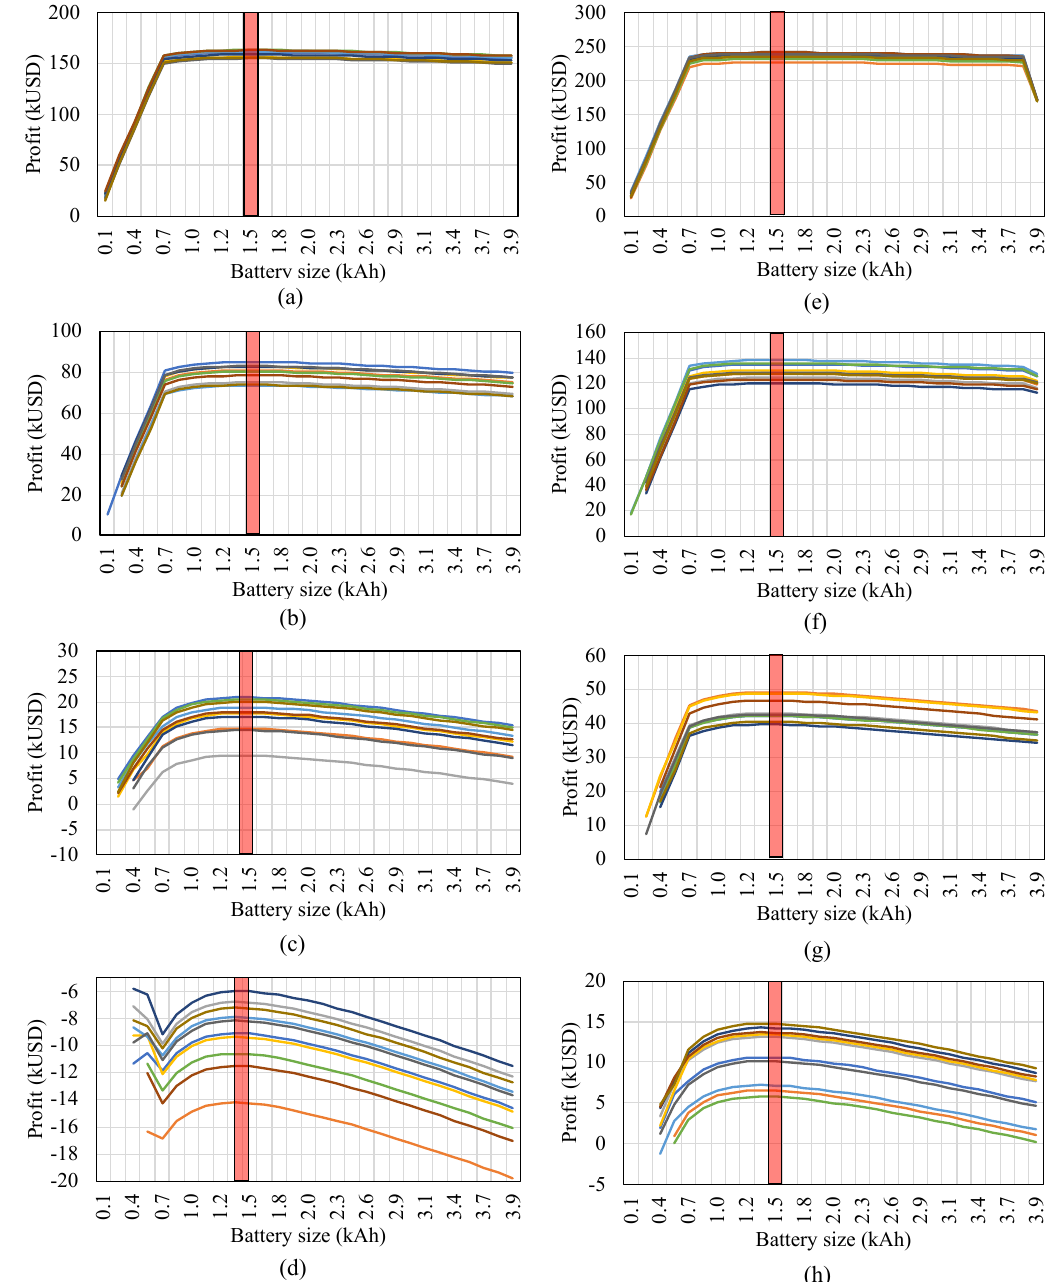
Figure 6. Annual profits by distributions of package weight and customer